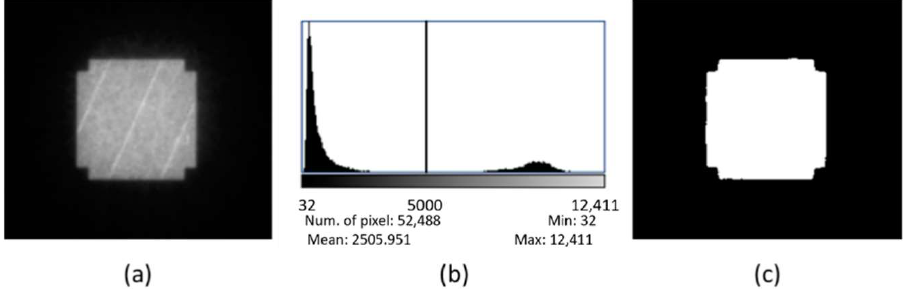
Figure 3. ( a ) Monitoring data of a part; ( b ) histogram of grey value of the monitoring data; ( c ) binarized monitoring data using 5000 as the threshold.